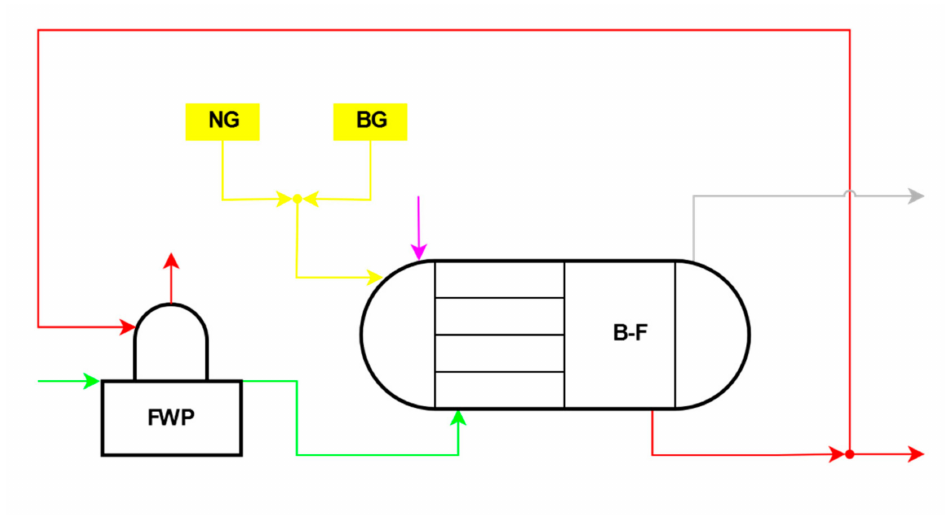
Figure 2. Simplified process flowsheet of the boiler room (light red—live steam from boiler room and exhaust steam from feed water preheater and degasser, green—feed water, purple—combustion air, yellow—fuel, grey—flue gas). NG – natural gas, BG – biogas, FWP – feed water preheater and degasser, B-F –